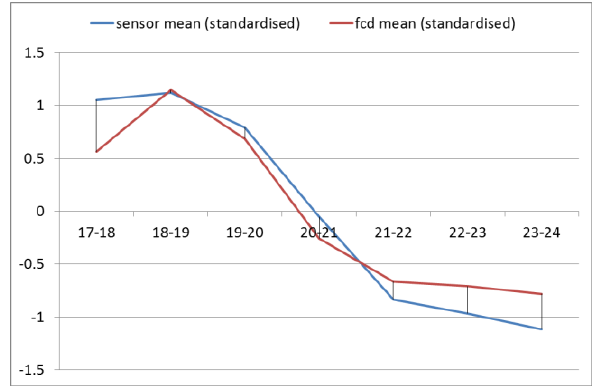
Table 2. Comparison, in terms of number of vehicles, between measures coming from loop sensors and FCD data